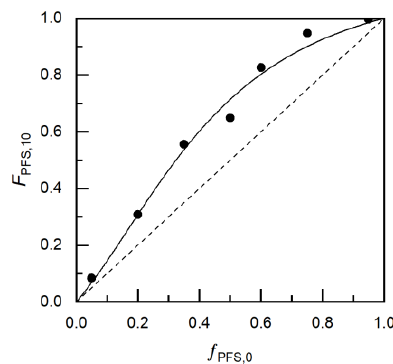
Figure 4. Mayo-Lewis plot of copolymer composition with respect to 2,3,4,5,6-pentafluorostyrene, F PFS,10 , versus monomer feed composition , f PFS,0 . The experimental data for MMA/PFS copolymerization is represented by solid circles, while the solid line shows the fit from the reactivity ratios calculated from the non-linear least-square fitting to the Mayo-Lewis equation ( r PFS = 3.50 ± 0.70 and r MMA = 0.20 ± 0.21). The straight dashed line indicates the azeotropic composition ( f PFS,0 = F PFS ). Table 2 lists the experiments used for the plots.